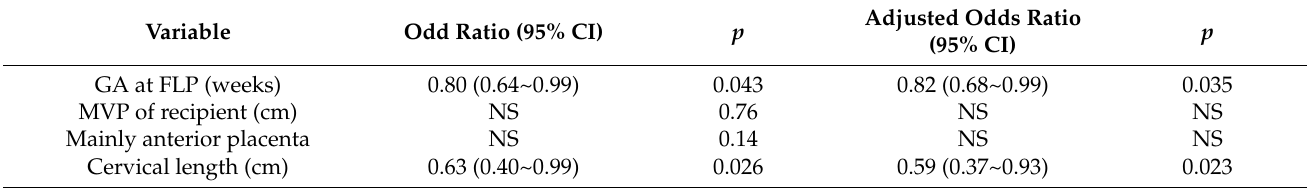
Table 4. Antenatal variables for preterm premature rupture of membranes within 21 days of FLP in severe cases of TTTS.